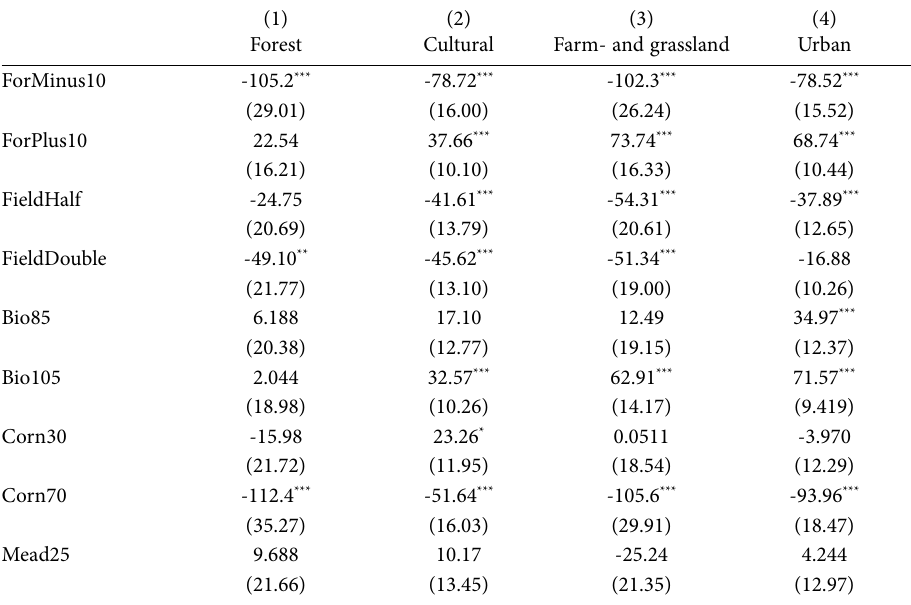
Table 9. Willingness to pay for different landscape models.